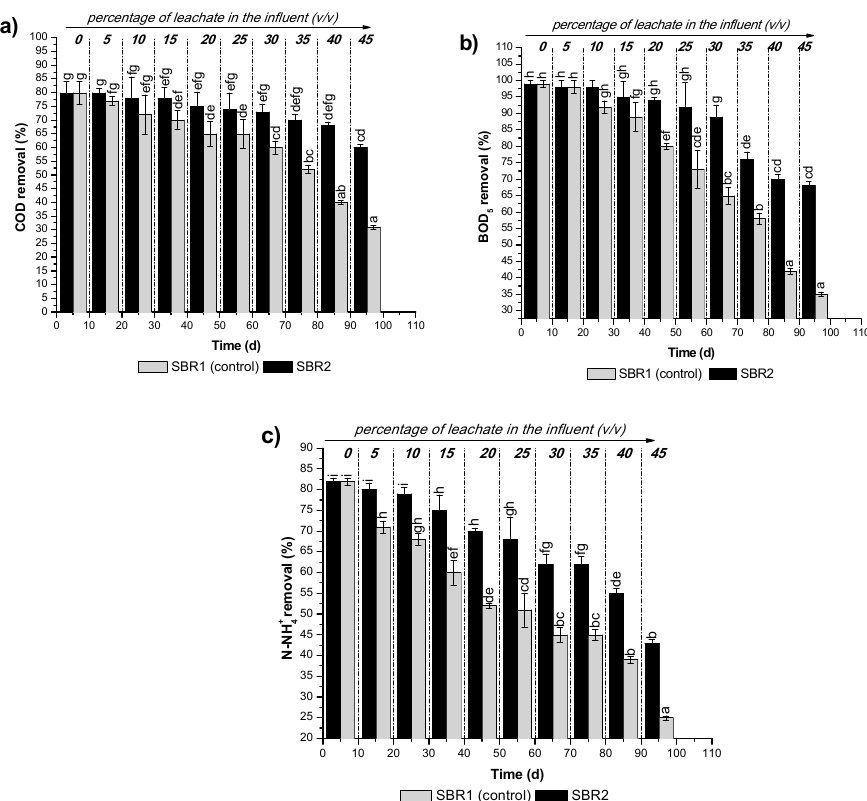
Figure 4. Variation of treatment efficiency during the experiment: ( a ) COD removal; ( b ) BOD 5 removal; ( c ) N–NH 4+